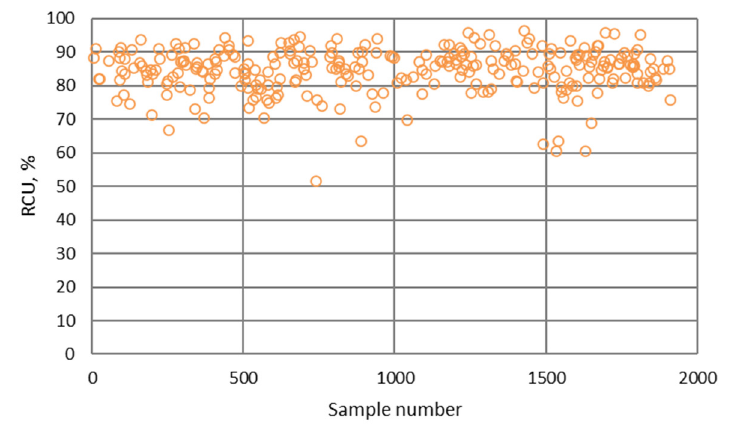
Figure A36. NN2 model—validation dataset.